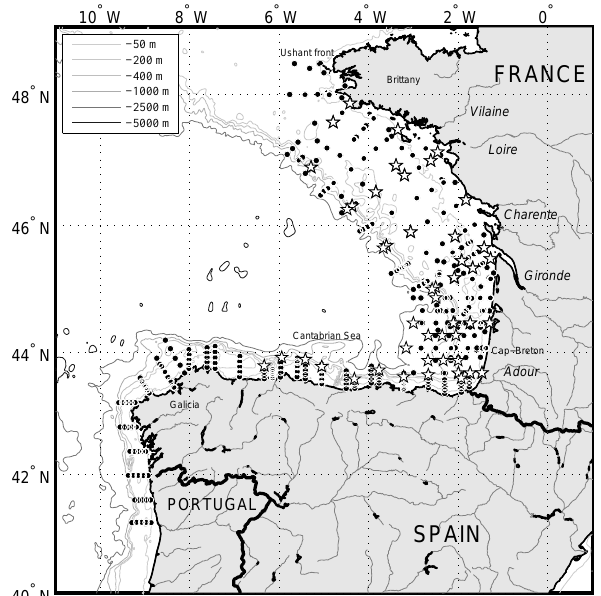
Figure 1. Map of the Bay of Biscay showing the location of stations (black circle for LOPC/CTD only and white star for LOPC/CTD and WP2 net).